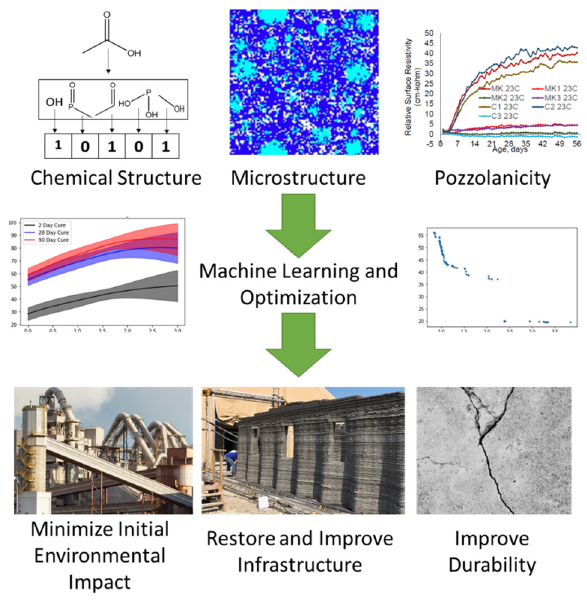
Figure 1. Latent variable representation of cement ‐ based materials (top) can be modeled and optimized through data science techniques (middle) to develop non ‐ incremental innovations and meet global goals for sustainable development (bottom).